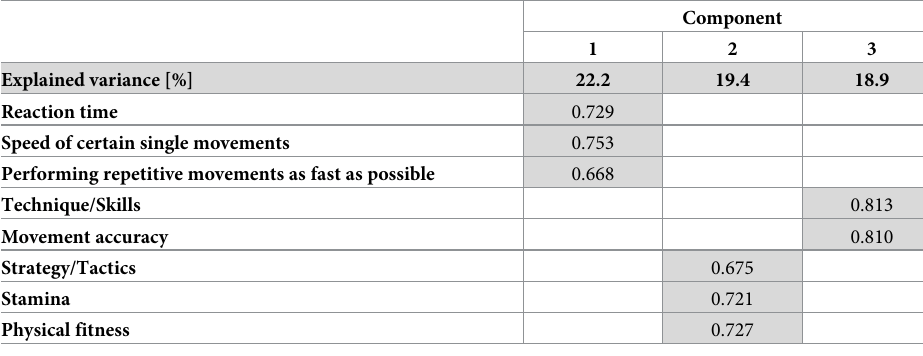
Table 24. Estimated training structure.